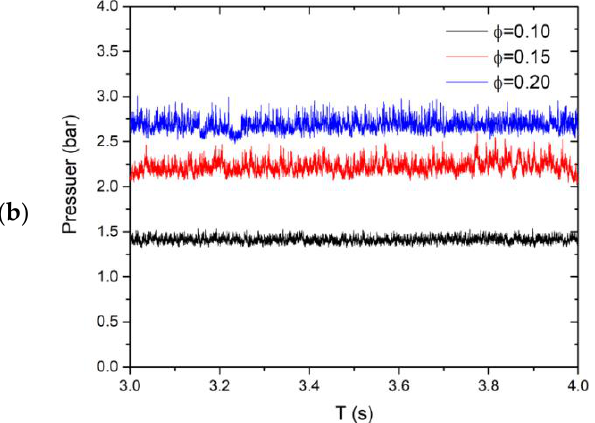
Figure 4. Pressure history of ( a ) points CH02 (front of fuel jet) and ( b ) CH03 (posterior edge of cavity).